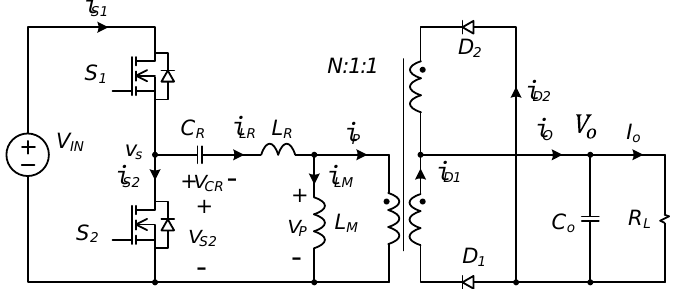
Figure 1. Basic circuit structure of half-bridge LLC resonant converter.